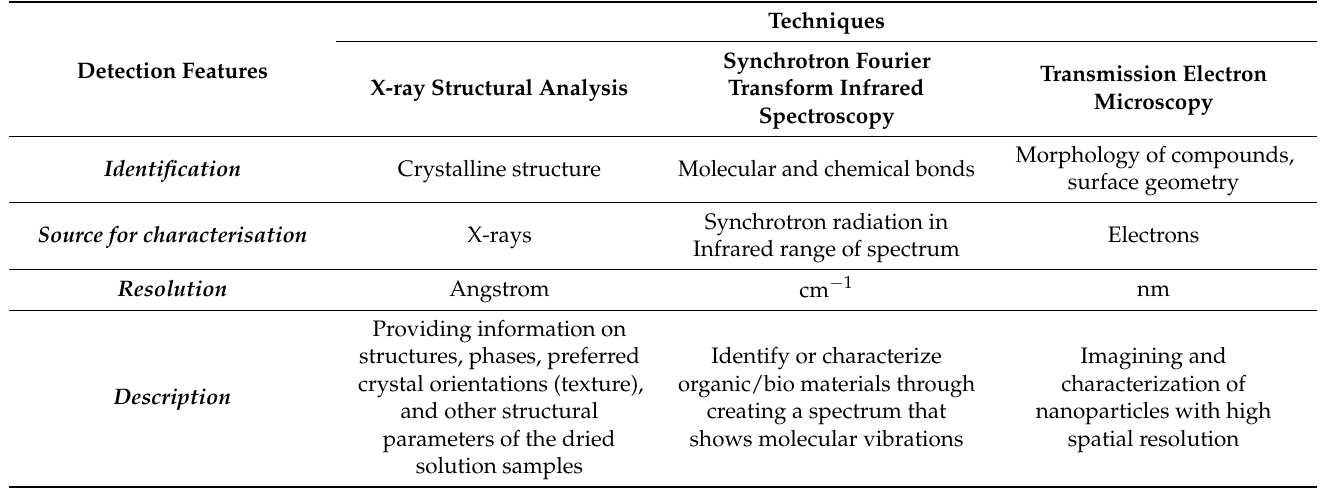
Table 1. Methods of structural and spectroscopic